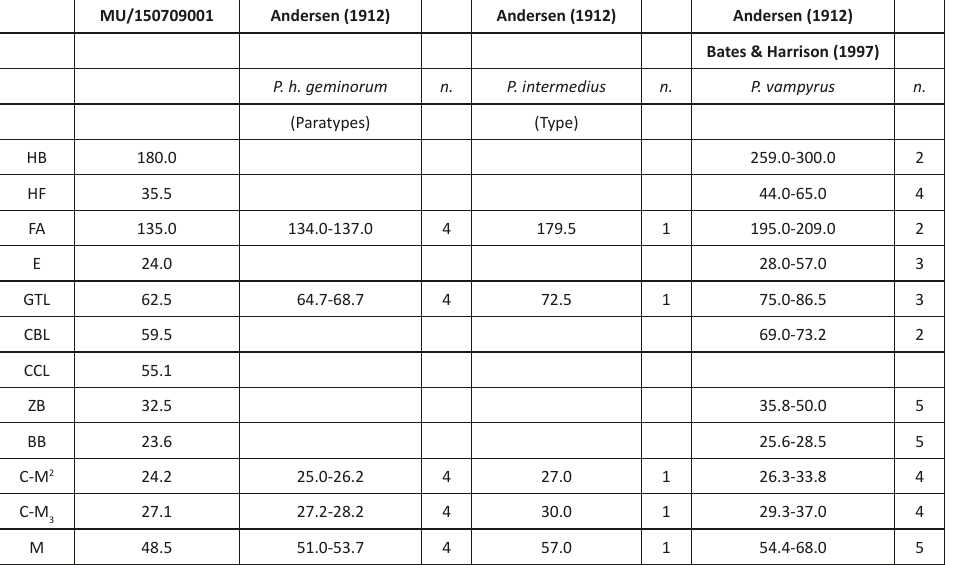
Table 1. Selected external, cranial, and dental measurements (in mm.) of specimen no. MU/150709001 from Myeik, Pteropus hypomelanus geminorum from South Twin Island, Pteropus intermedius from Kyaikkami (Amherst), and Pteropus vampyrus from Indonesia, Malaysia, Singapore, and